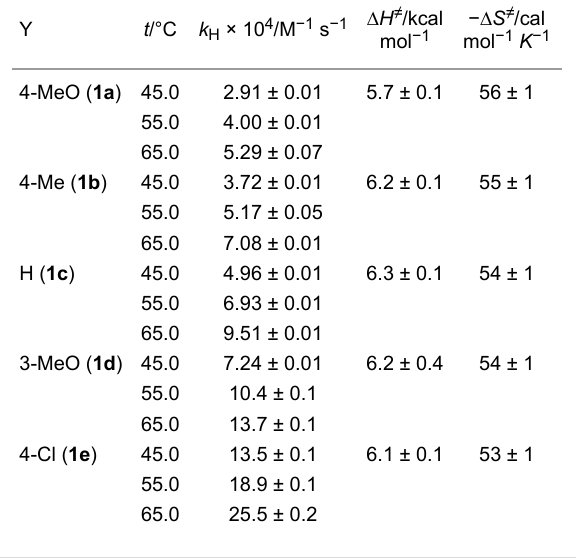
Table 5: Activation parameters for the reactions of Y-aryl phenyl iso- thiocyanophosphate with aniline (C 6 H 5 NH 2 ) in